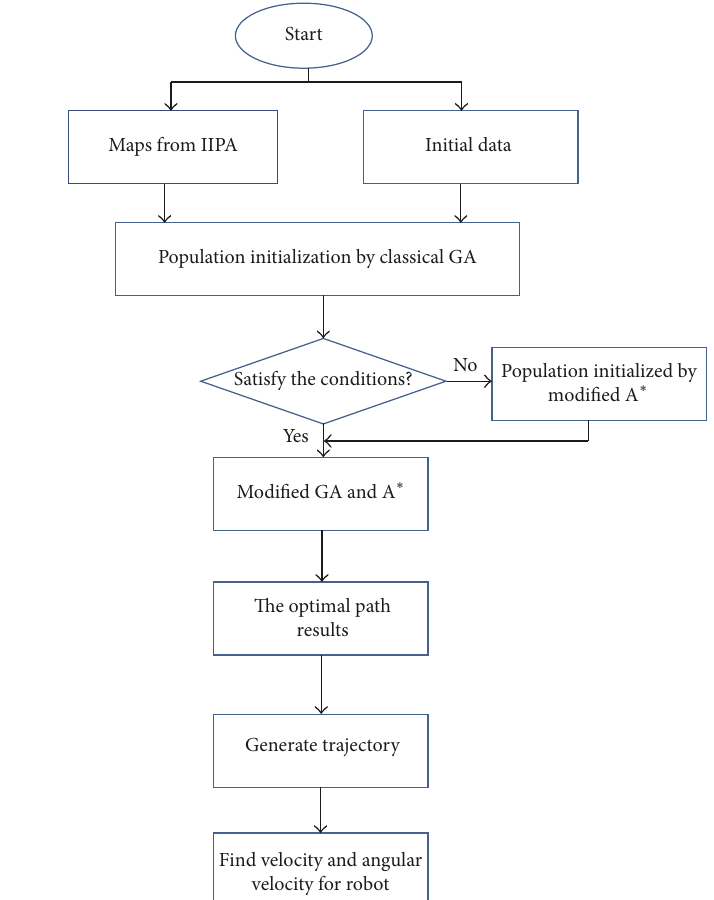
Figure 12: Flow chart of the proposed GA.